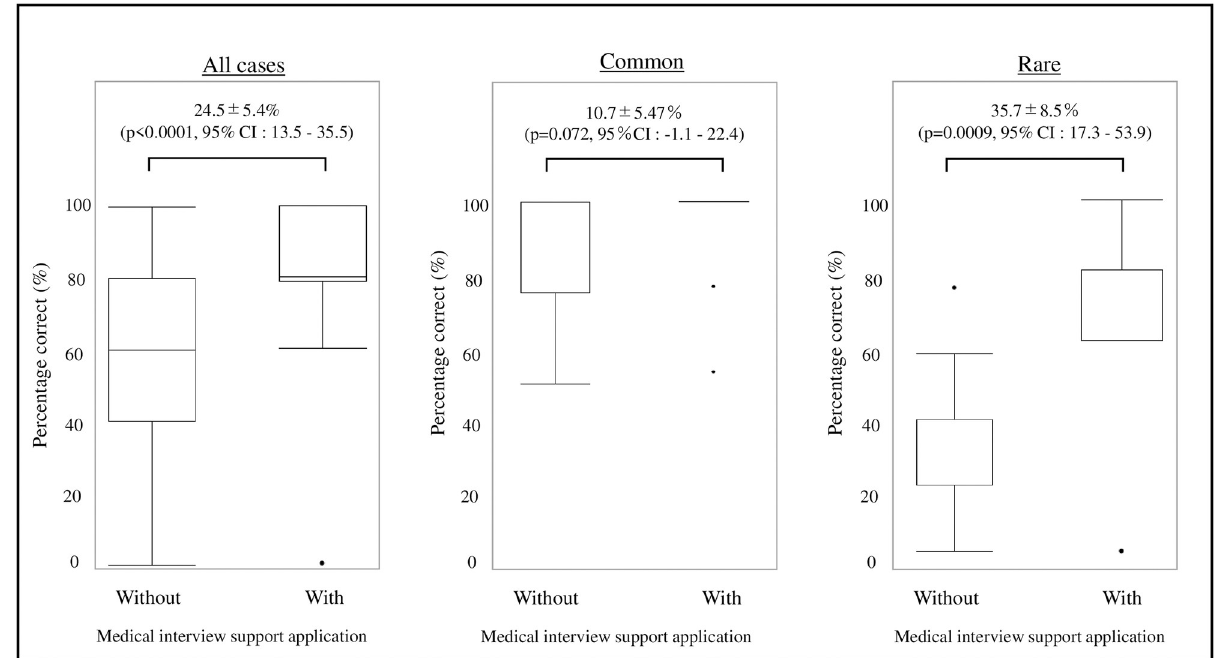
Fig 2. Comparison of correct answer percentages. Comparison of all cases revealed that the group that used the interview support application showed a significantly higher rate of correct answers. When validated by the frequency of diseases, the use of the interview support application increased the rate of correct answers in the rare disease